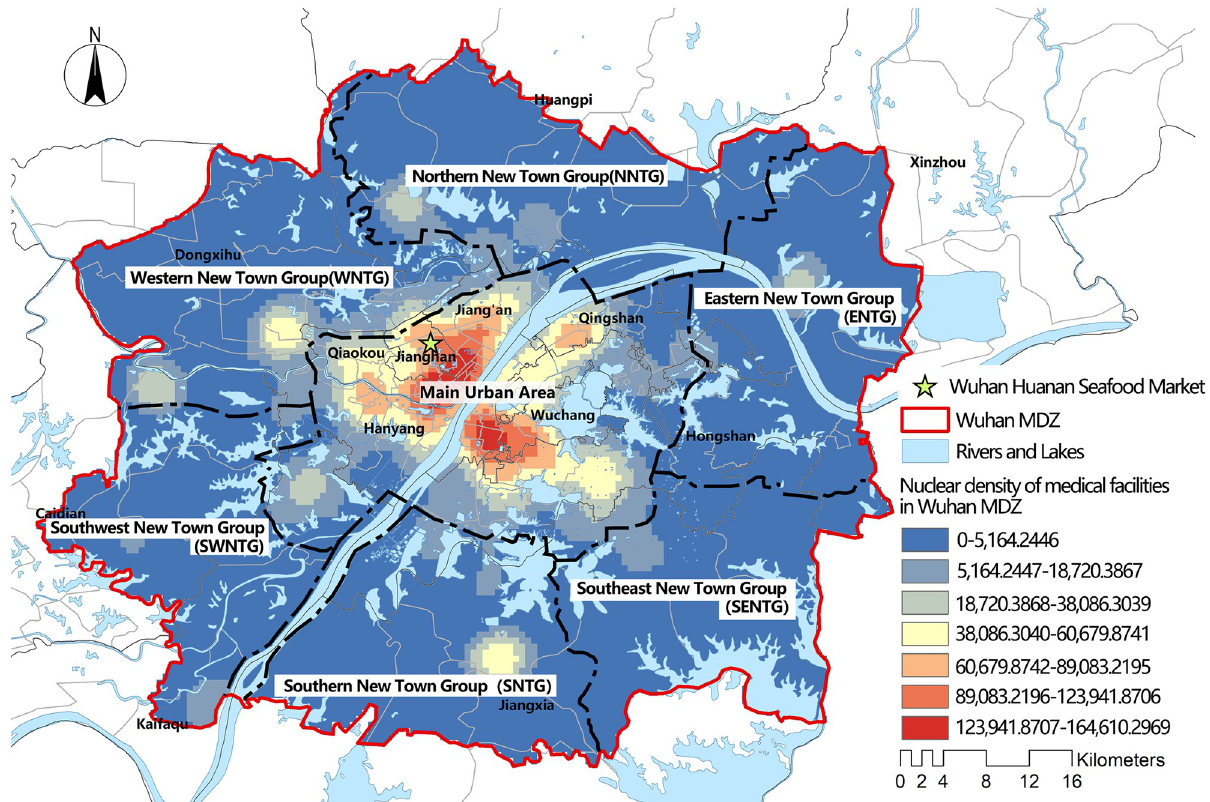
Fig 3. "1 + 6" space structure and nuclear density estimation map of medical facilities in the Wuhan MDZ.